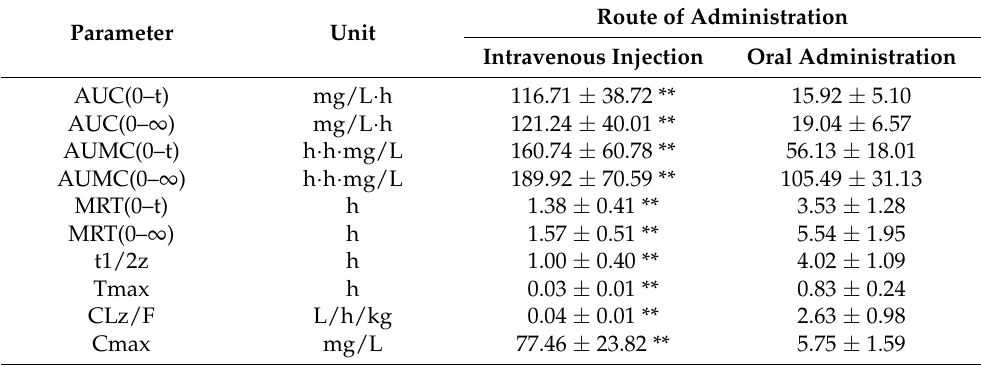
Figure 3. Mean plasma concentration–time curves after intravenous administration of 5 mg/kg Table 9. Main pharmacokinetic parameters of imperatorin after intravenous administration of 5 mg · kg − 1 imperatorin lipid microspheres and oral administration of 50 mg · kg − 1 imperatorin in rats (mean ± SD, n = 6).